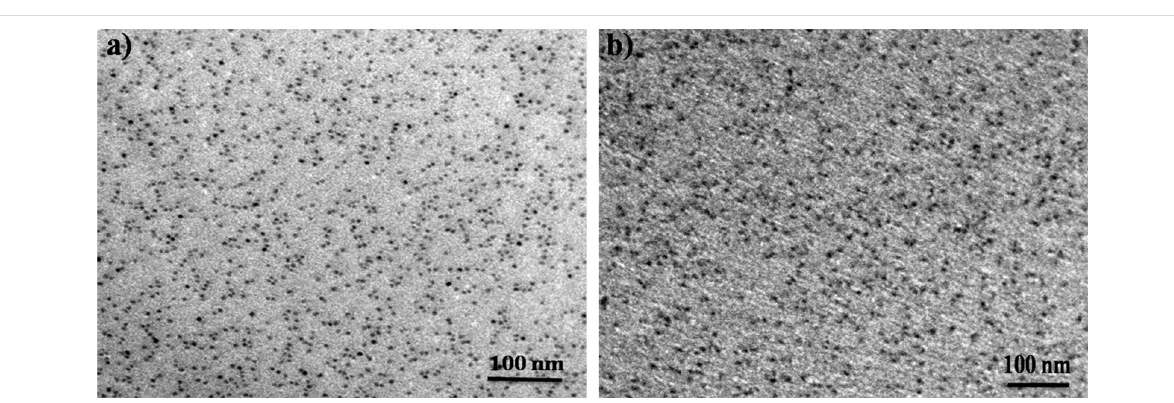
Figure 4: TEM micrographs of 10 atomic % Zn in silica, (a) pristine film, (b) irradiated at a fluence of 3 × 10 13 ions/cm 2